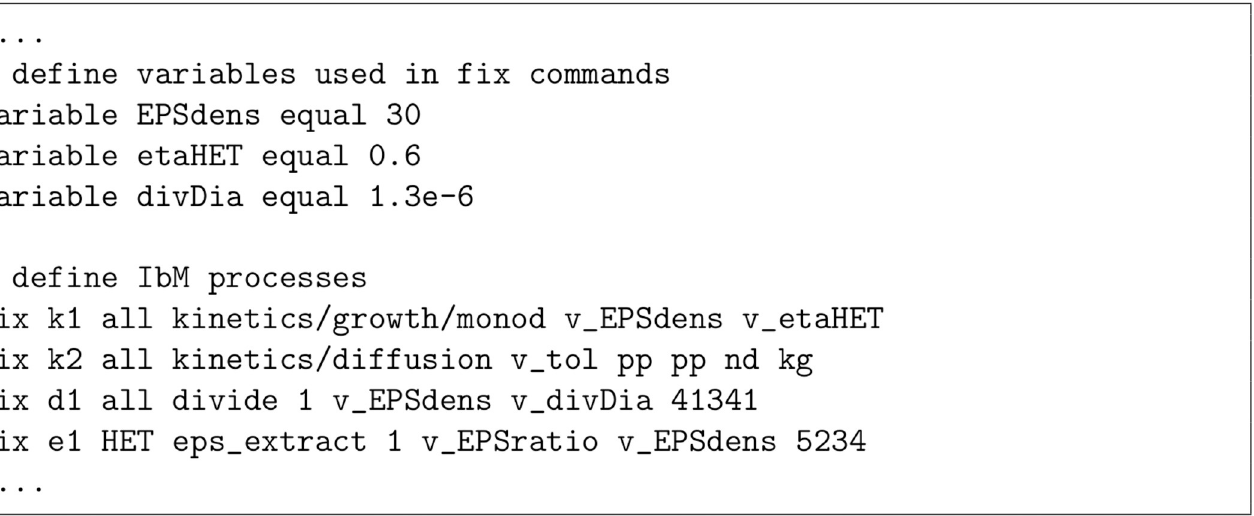
Fig 2. An example of (partial) input script for NUFEB simulation. A list of “fix” commands defines IbM processes that apply to the simulation, which includes Monod-based growth ( k1 ), nutrient mass balance ( k2 ), cell division ( d1 ), and EPS production ( e1 ). Each fix command may require one or more parameters for the model specification, such as EPS density ( EPSdens ), division diameter ( divDia ), and HET reduction factor in anoxic condition ( etaHET ). The last parameter is introduced due to the fact that the observed growth rate of HET in anoxic condition was always smaller than that in aerobic condition.